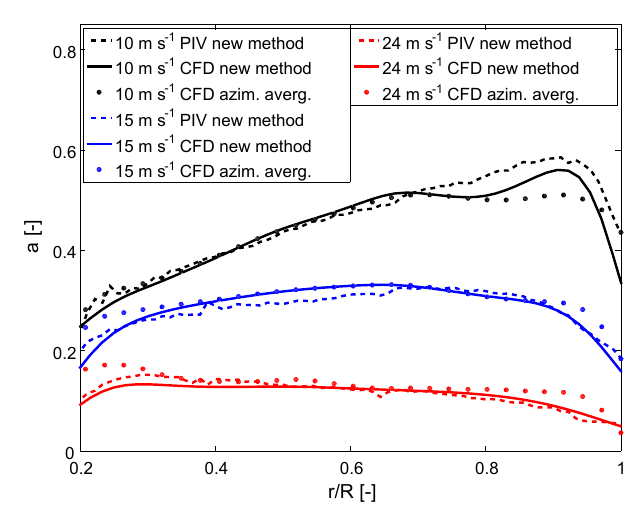
Figure 3. Axial induction factor along the rotor radius. Figure 4. Tangential induction factor along the rotor